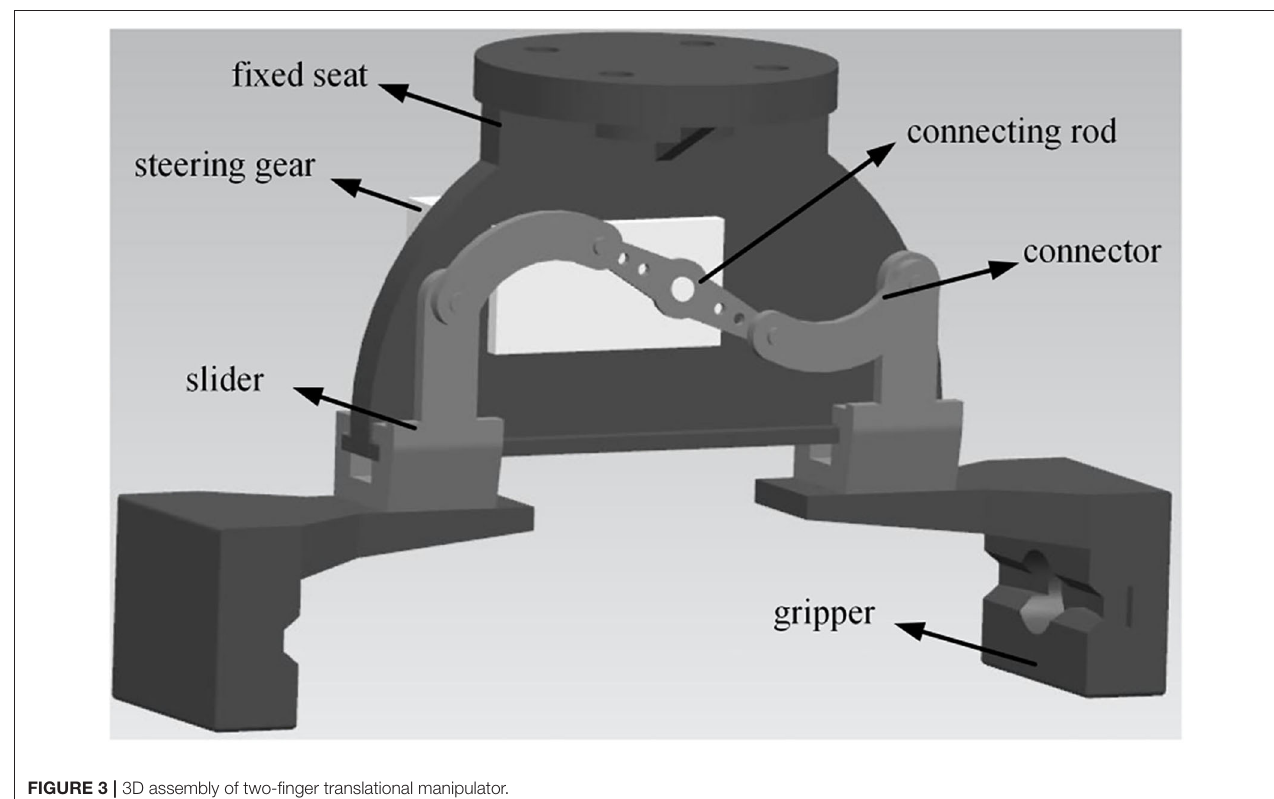
FIGURE 3 | 3D assembly of two-finger translational manipulator.